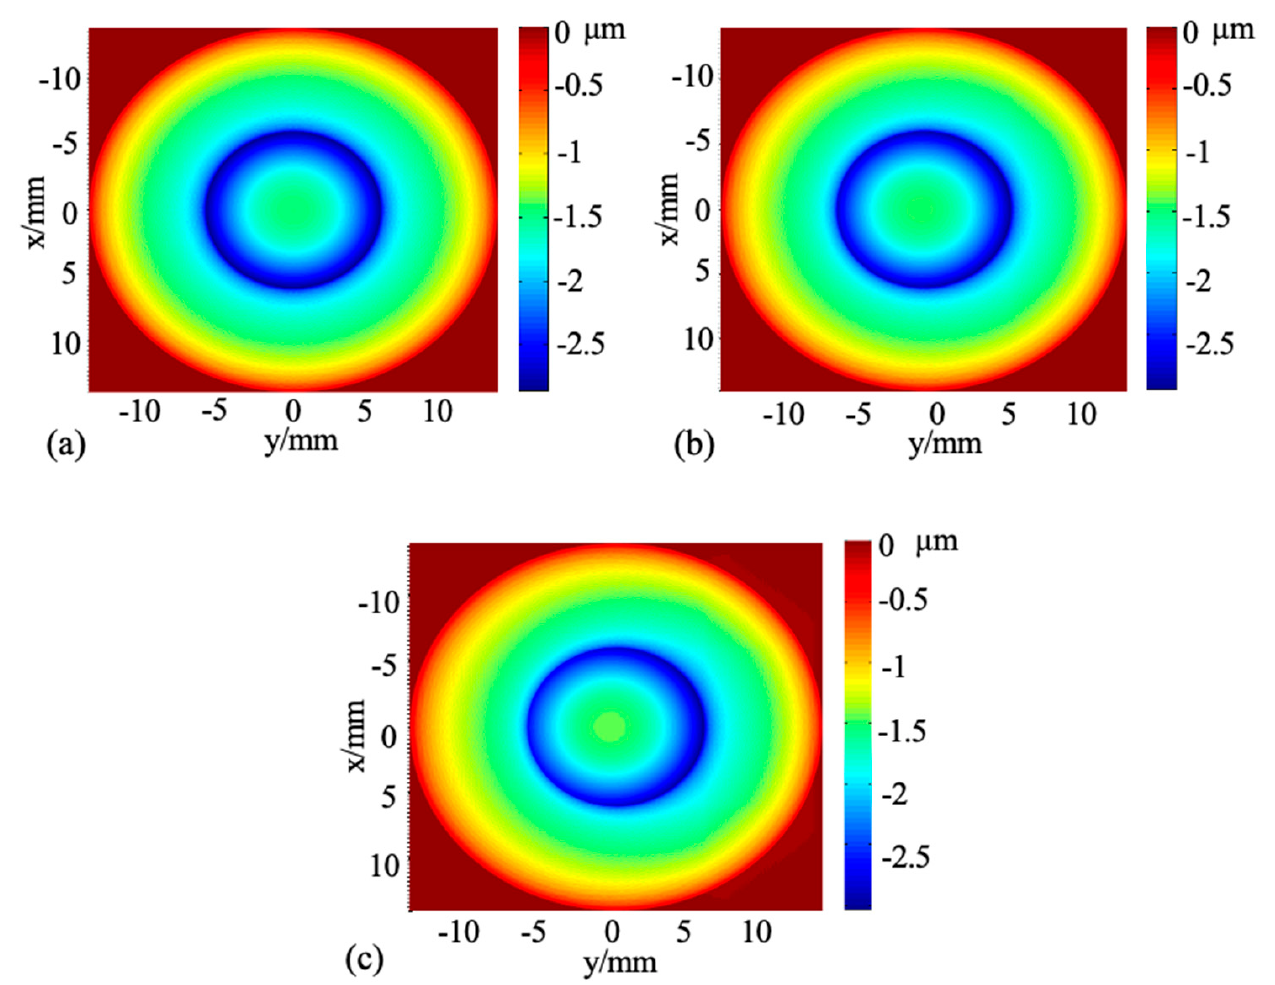
Figure 7. 3D material removal characteristics when normal errors of polishing tool were ( a ) 0°, ( b ) 0.5°, and ( c ) 1°.